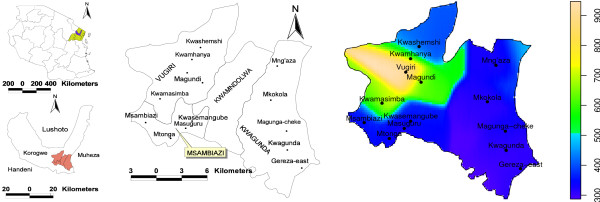
Map showing wards (in capitals) and study villages (in lowercase) in Korogwe District (centre map). Top left, is the map of Tanzania showing location of Korogwe district within the Tanga region, while the bottom left, is the map of Korogwe district showing the location of the study villages. Coloured map shows elevation of the study area (metres above sea level) as calibrated in the legend